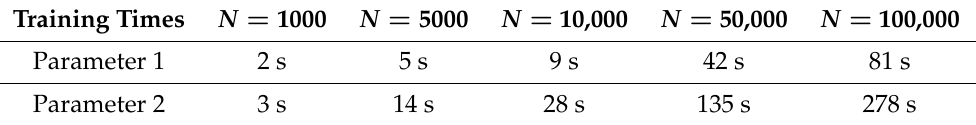
Table 5. The CPU time of the Monte Carlo method under different paths. Path Number N = 1000 N = 5000 N = 10,000 N = 50,000 N = 100,000 ∆ t = 0.01 1 s 6 s ∆ t =